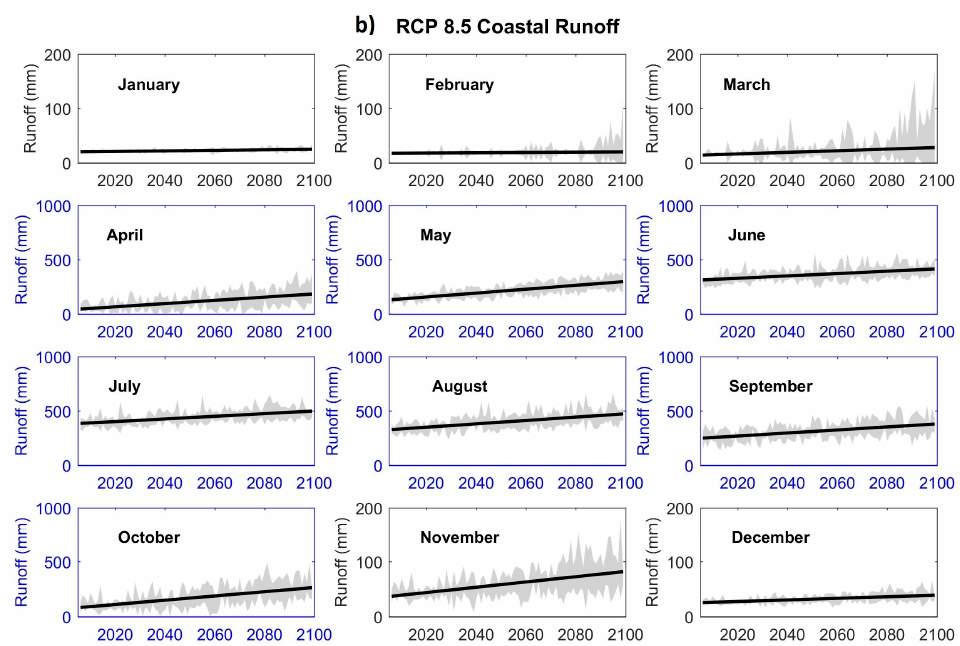
Figure 7. Trends in monthly runoff for scenarios RCP 4.5 ( a ) and RCP 8.5 ( b ) from the coastal portion of the watershed, which comprises the Chugach and St. Elias Mountains. Gray shaded regions represent one standard deviation around the mean of five CMIP5 models, and where a solid black trendline is present, it indicates the presence of a statistically significant trend in the five-model mean simulations (MM45 or MM85). Runoff during high-flow months (identified by blue axes) is illustrated at a different scale than during low-flow months (black axes).